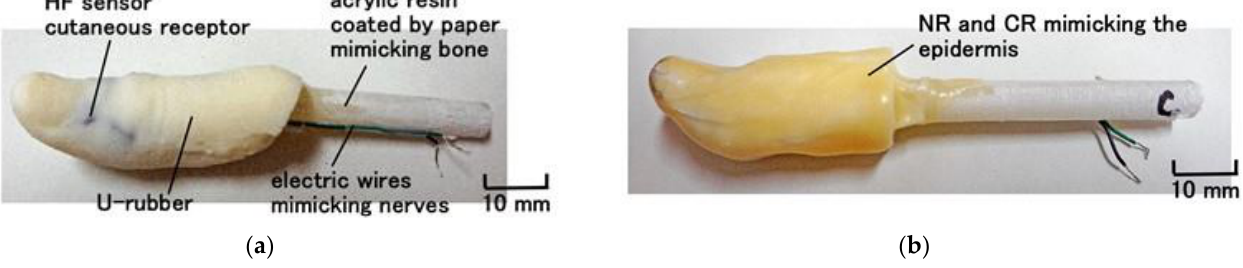
Figure 13. Photographs of a finger with each of the cutaneous receptors: ( a ) before coating with mixed NR and CR; ( b ) after coating with mixed NR and CR.